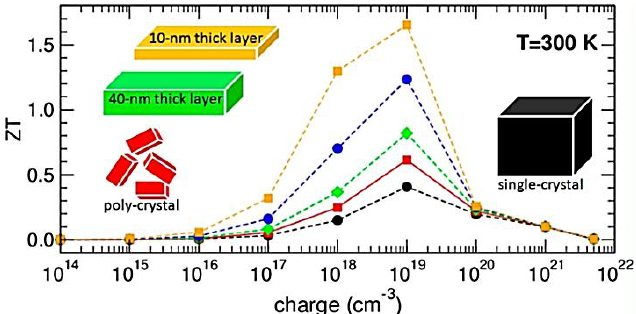
Figure 13. ZT vs. charge concentration for electron-doped CH 3 NH 3 PbI 3 , calculated at 300 K. Black dots and red squares correspond to single crystal and polycrystal CH 3 NH 3 PbI 3 , respectively; the other symbols are for mimicking ZT value in 2D wells of thickness L = 40 nm (green diamonds), 20 nm (blue circles), and 10 nm (orange squares). Reproduced with permission [33]. Copyright 2016, American Chemical Society.